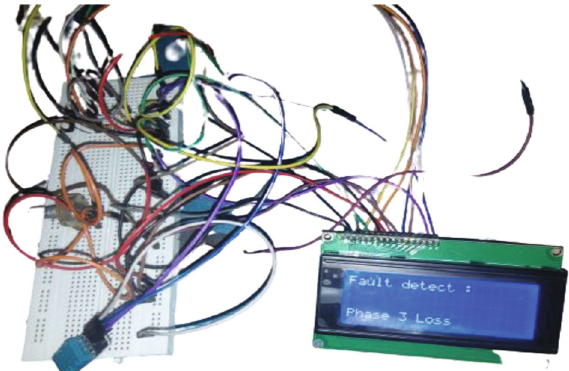
Figure 7: Real-time photo of phase failure condition.